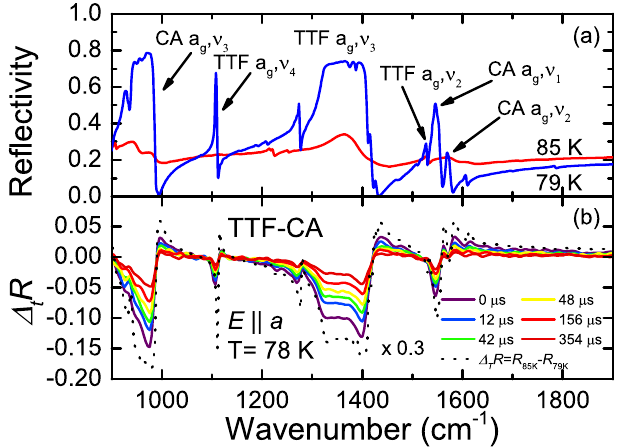
Figure 24. ( a ) Reflectivity of TTF-CA along the stacking direction in the mid-infrared frequency range for T = 79 K (red) and 85 K (blue). The a g modes become strongly enhanced due to the dimerization of the TTF and CA pairs in the ionic phase; ( b ) Temporal sequence of the reflectivity change ∆ t R = R ( t ) − R ( 0 ) (solid lines) after photo excitation depicted for various delay times and directly compared to the static reflectivity difference ∆ T R = R 85K − R 79K (dashed line). Adapted from